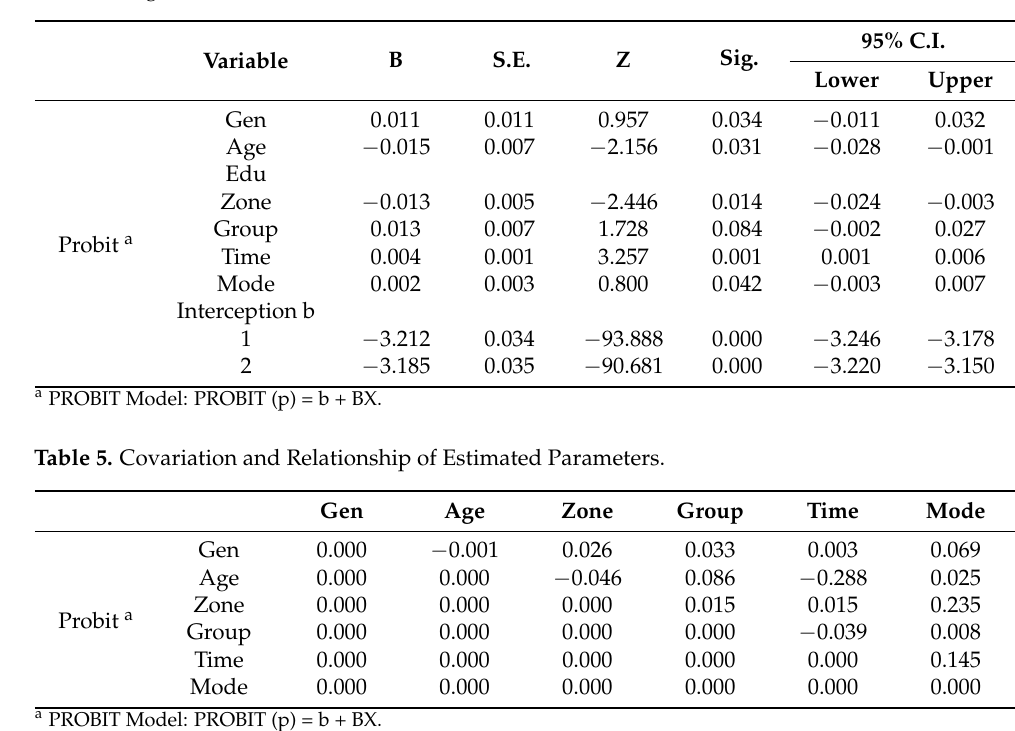
Table 4. Regression of Model Parameters.